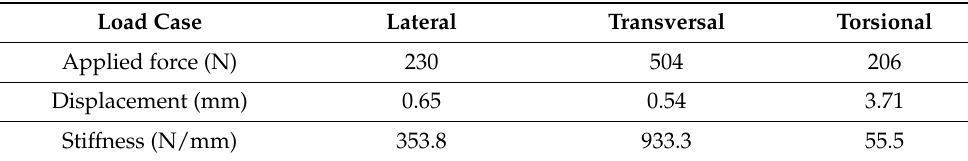
Table 5. Measured stiffness of the composite hood “B”.